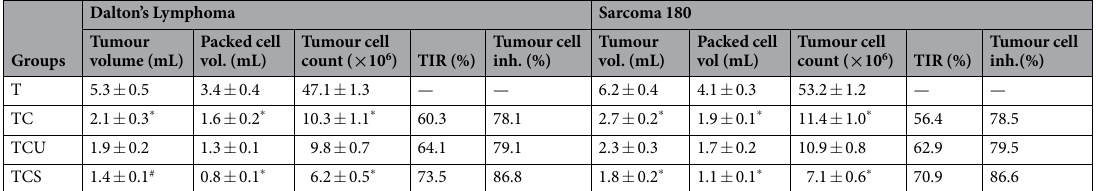
Dalton’s Lymphoma Groups